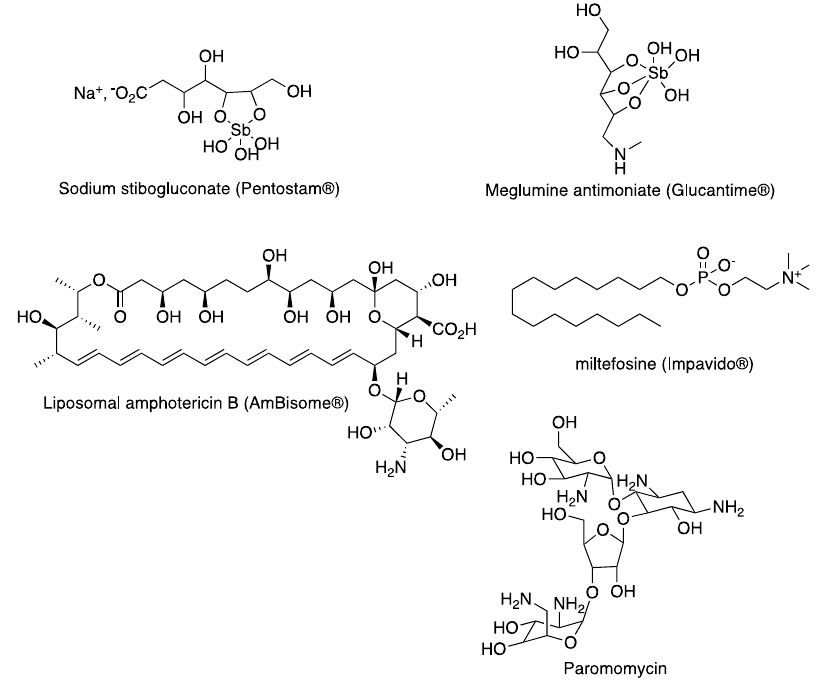
Figure 1. Antileishmanial drugs most currently used in clinics.